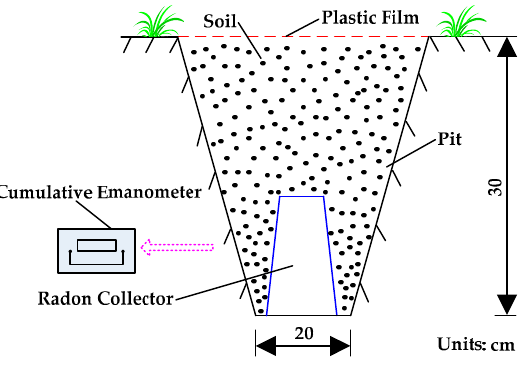
Figure 4. Schematic of a radon collector embedded in the pit at an RMP.